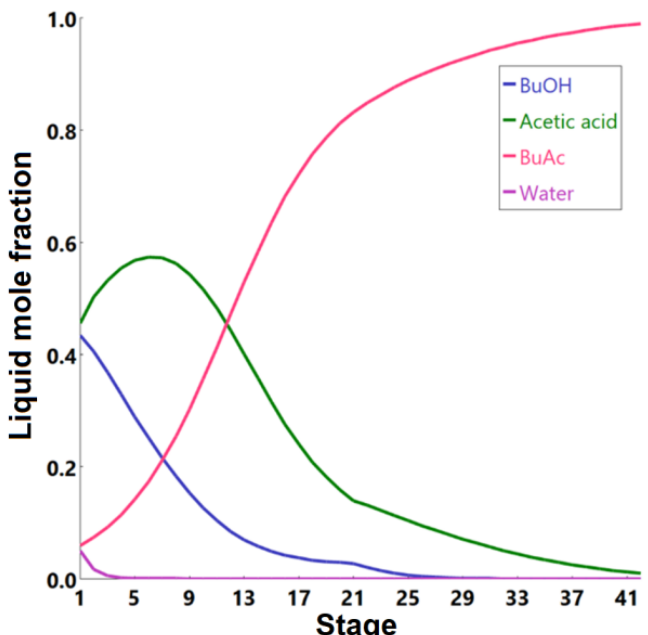
Figure 9. Equilibrium x - y diagram of n -butanol/butyl acetate mixture at: ( a ) 101 kPa and ( b ) 304 kPa.